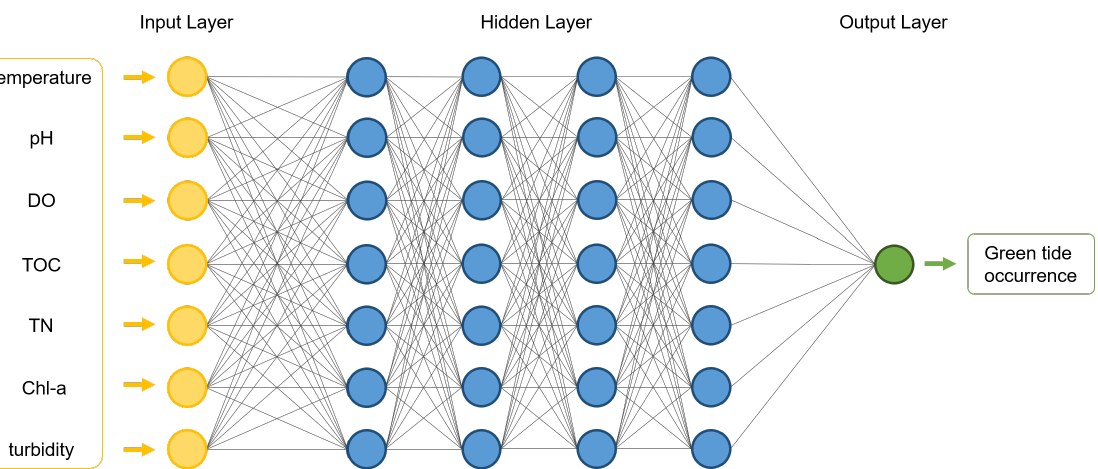
Figure 5. ML/DL-based green tide phenomenon prediction neural architecture.